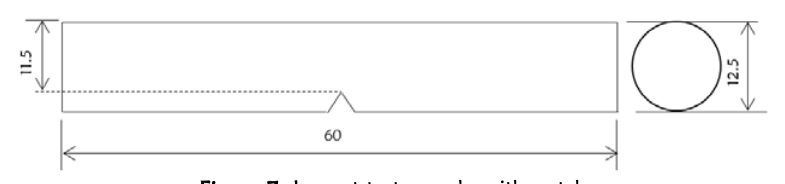
Figure 7: Impact test sample with